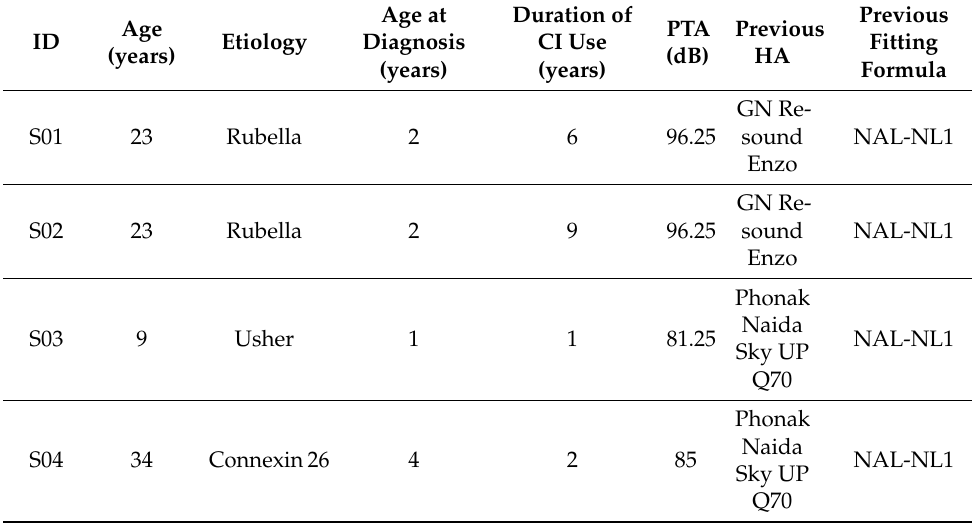
Table 1. Detailed demographic